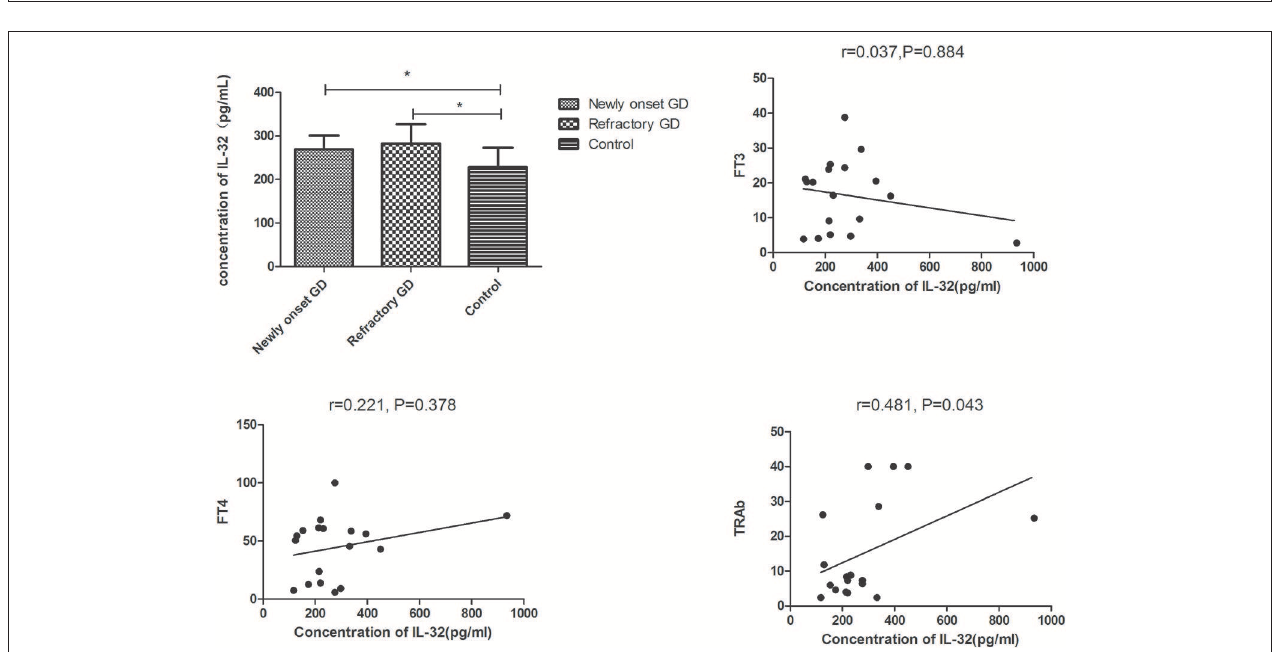
FIGURE 3 | Serum IL-32 levels of GD patients and healthy controls. Serum IL-32 level of GD patients was significantly elevated compared with controls. No correlation was found between IL-32 concentration and FT3, FT4, and TRAb (all P > 0.05). ** P < 0.01.